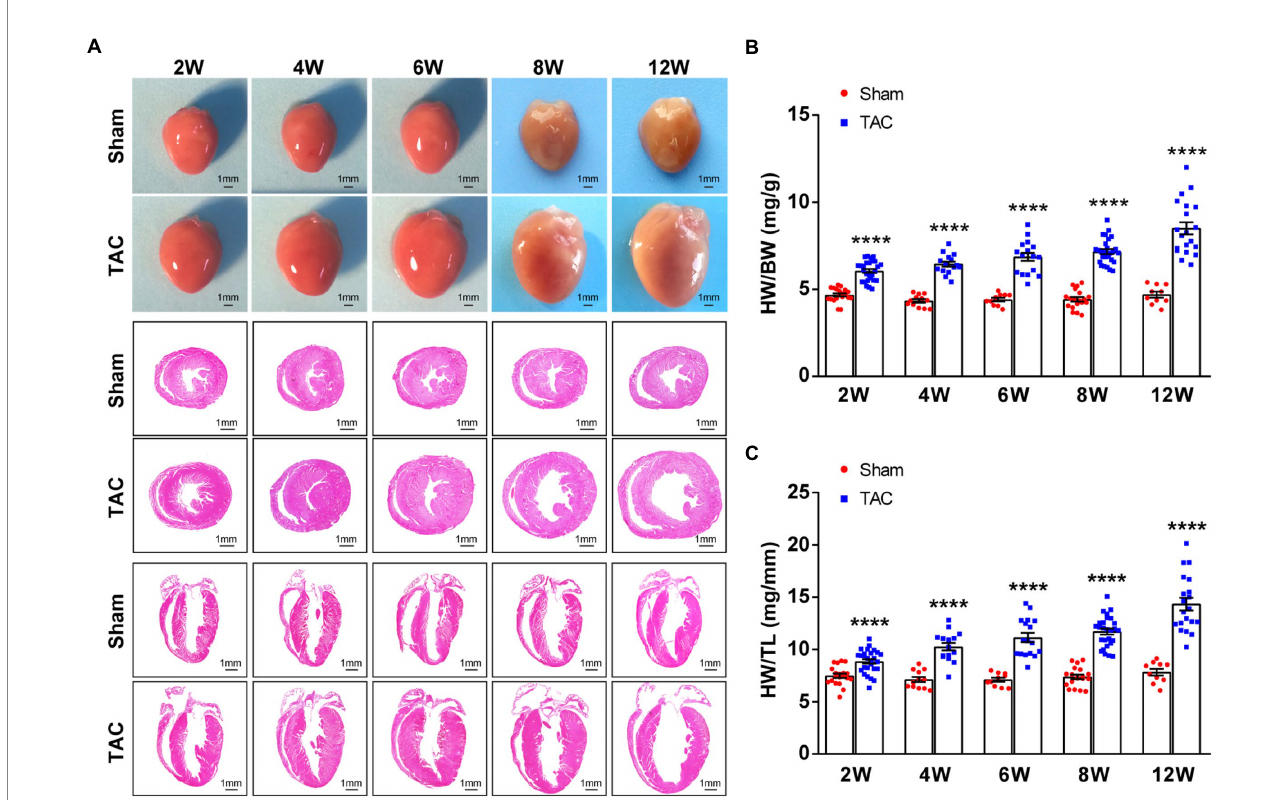
FIGURE 6 Mouse heart weight and size had a time-series increase after TAC. (A) Representative gross heart of mice at various times upon surgery (top), representative images of hematoxylin and eosin (H&E) staining of heart section across the heart’s short axis (transverse section) at various times upon surgery (middle), and representative images of H&E staining of heart section along the heart’s long axis (coronal section) at various times upon surgery (bottom). (B) HW/BW ratios at various times upon surgery. (C) HW/TL ratios at various times upon surgery. n = 10~27. Unpaired t -test for two-group comparisons, **** p < 0.0001 vs. the corresponding